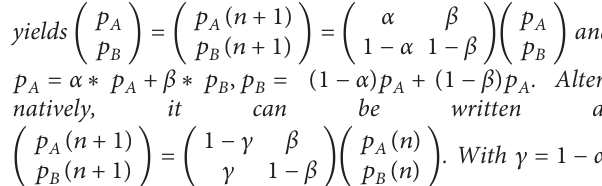
� 0.3, f � 0.3, f � 0.1, s � 100, p � 0.9, p � 0.1, μ � 0.0, σ � 0.1, p0 p1 m r e